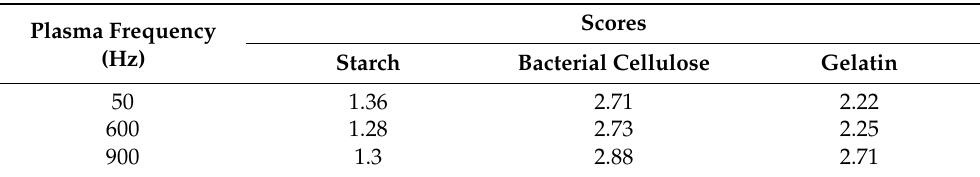
Table 7. Scores obtained for the desirability function used to select the best starches, bacterial cellulose, and gelatin films’ processing